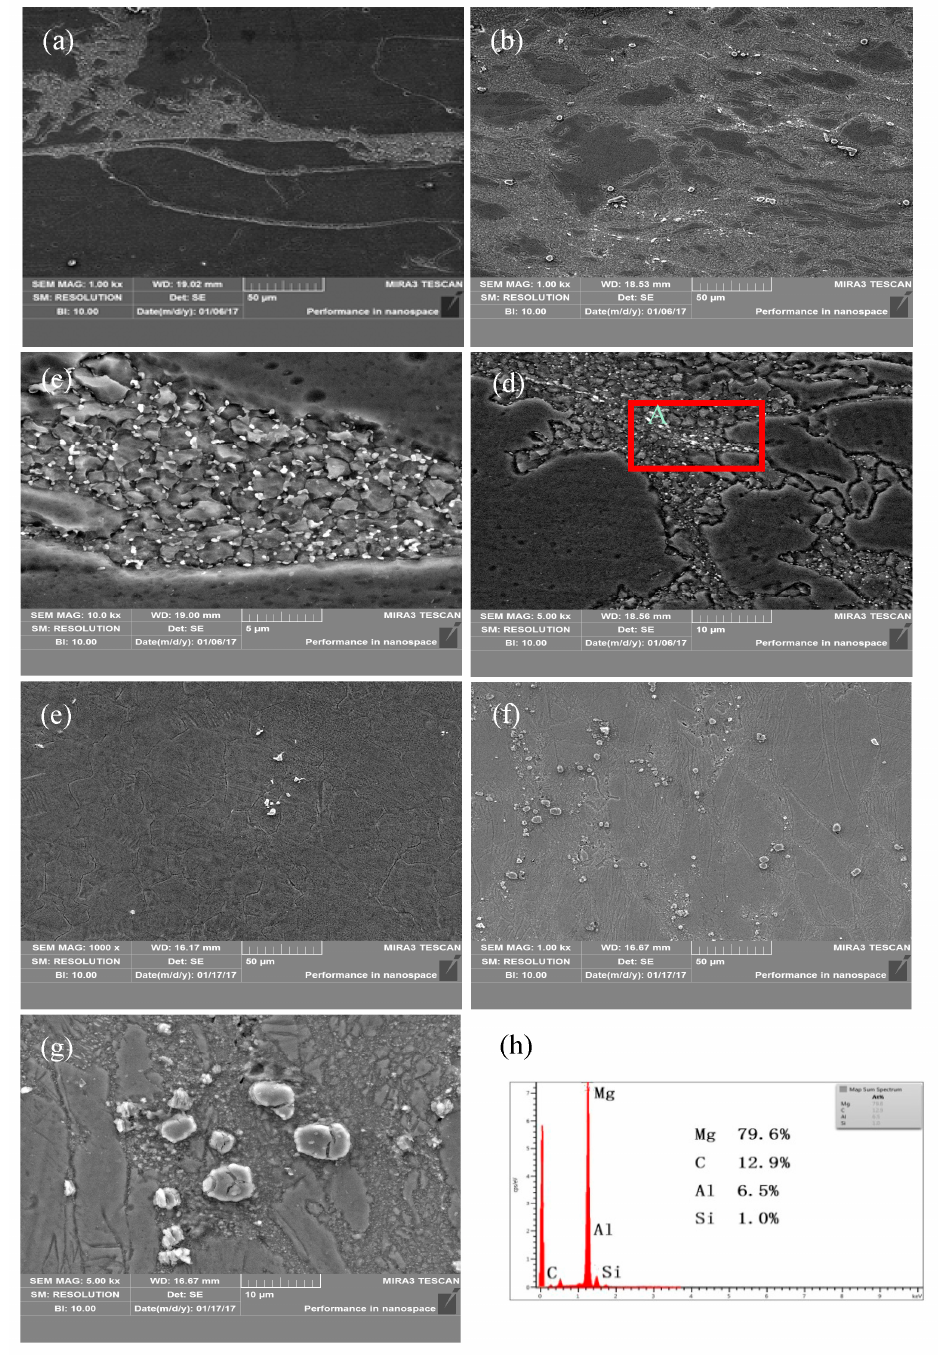
Figure 5. SEM images of ( a , c , e ) AZ91 alloy, ( b , d , f , g , h ) composite after hot compression: ( a , b ) 573 K, 0.01 s − 1 ; ( e , f ) 673 K, 0.001 s − 1 ; ( c , d ) the high magnification of ( a , b ) respectively; ( g ) the high magnification of ( f ); ( h ) the EDS of area “A” in ( d ). (Red rectangular frame “A” indicates the region of EDS